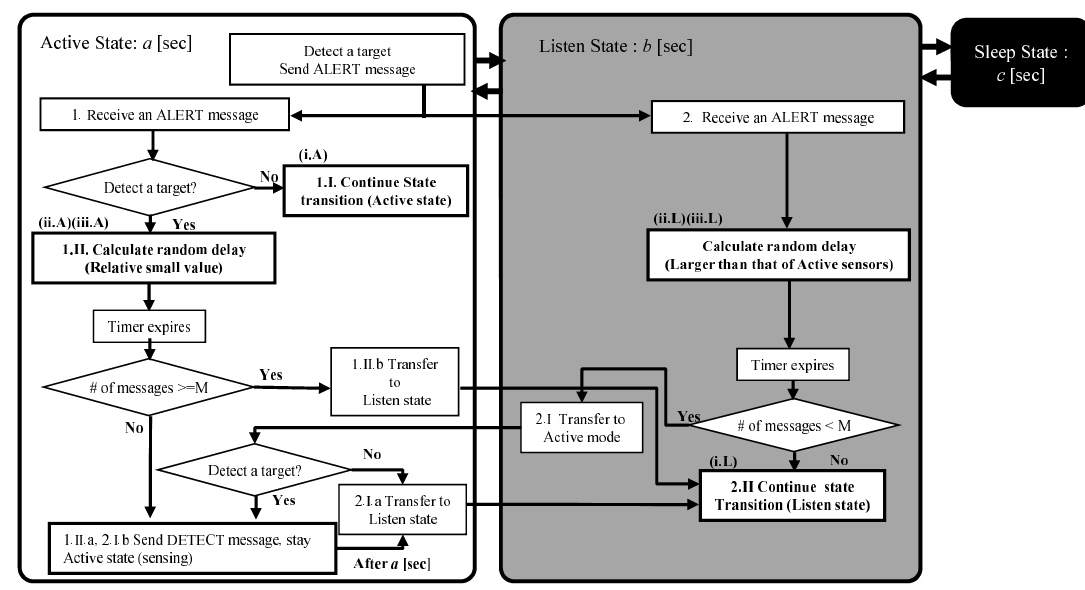
Figure 3. Monitoring sensor decision